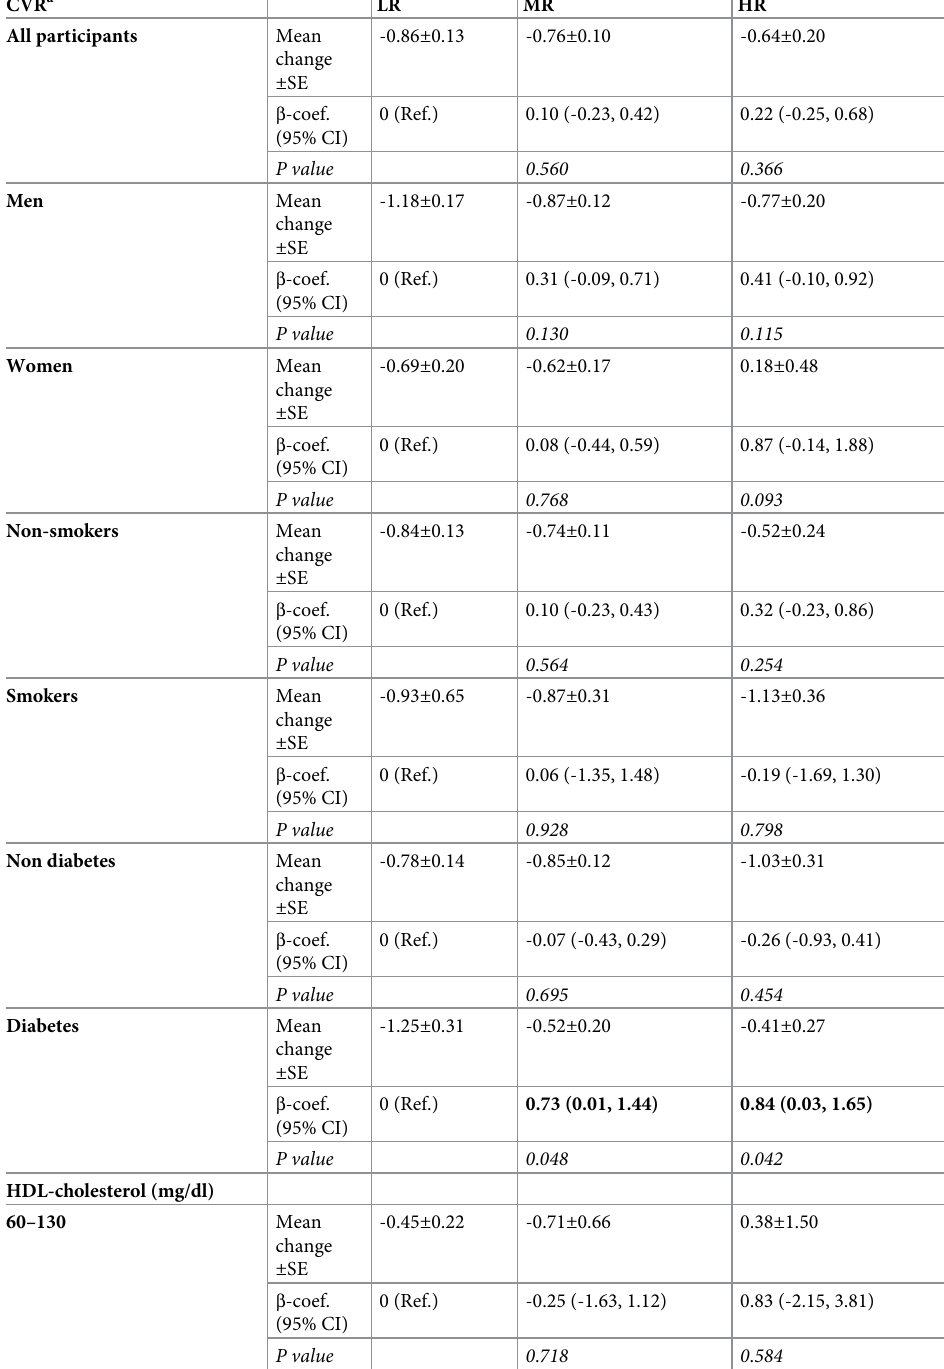
Table 4. Longitudinal associations between baseline CVR and 2 years changes in BDI-II score in participants with a BDI-II score < 18 in the PREDIMED-PLUS trial at